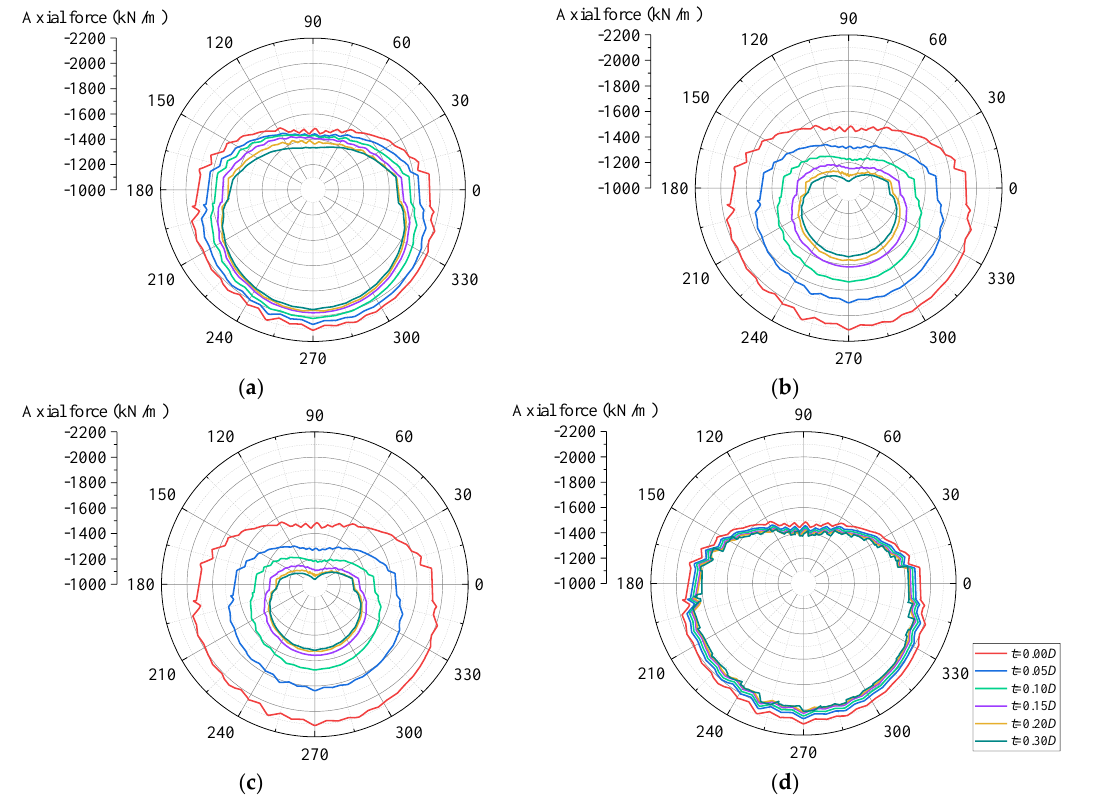
Figure 10. Axial force of the lining of preceding tunnel under different cases: ( a ) RR; ( b ) LR; ( c ) TR; ( d ) CR.